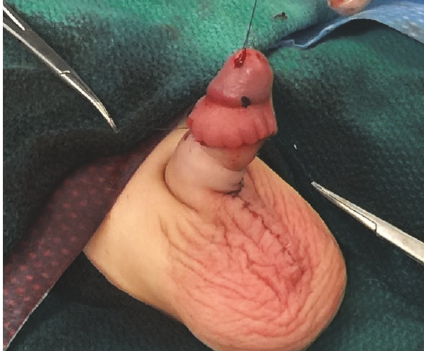
Figure 3: Good recreation of the penoscrotal and penopubic angle is shown, in addition to scrotal reapproximation at the midline.